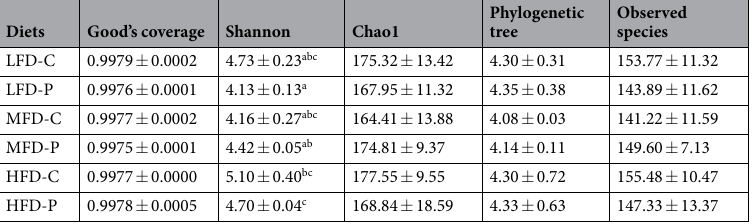
Table 1. Alpha diversity metrics of Good’s coverage, Shannon’s, Chao1diversity, phylogenetic diversity and observed species of zebrafish (mean ± s.d.; n = 3, except for LDF-P n = 2). a,b Values in the same column with the different superscripts are significantly different ( p < 0.05).